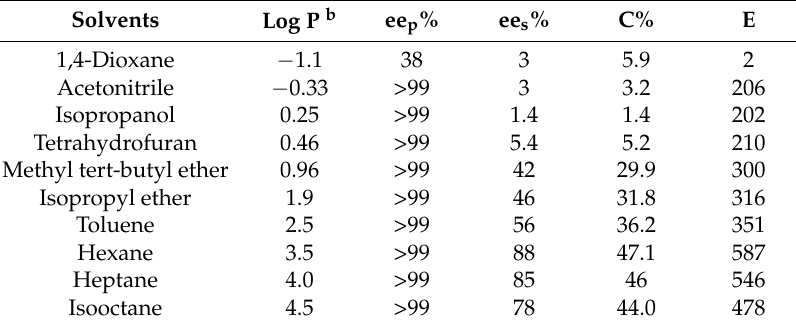
Table 1. Effect of solvent on the resolution of 1-phenylethanol a .